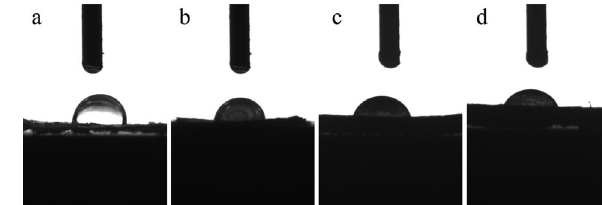
Figure 5: Water contact angle image of carboxyl exposed PET (a), PET/ZnO (b), PET/ZnO/TTCP (c) and PET/ZnO/TTCP/Gel (d) woven nets.